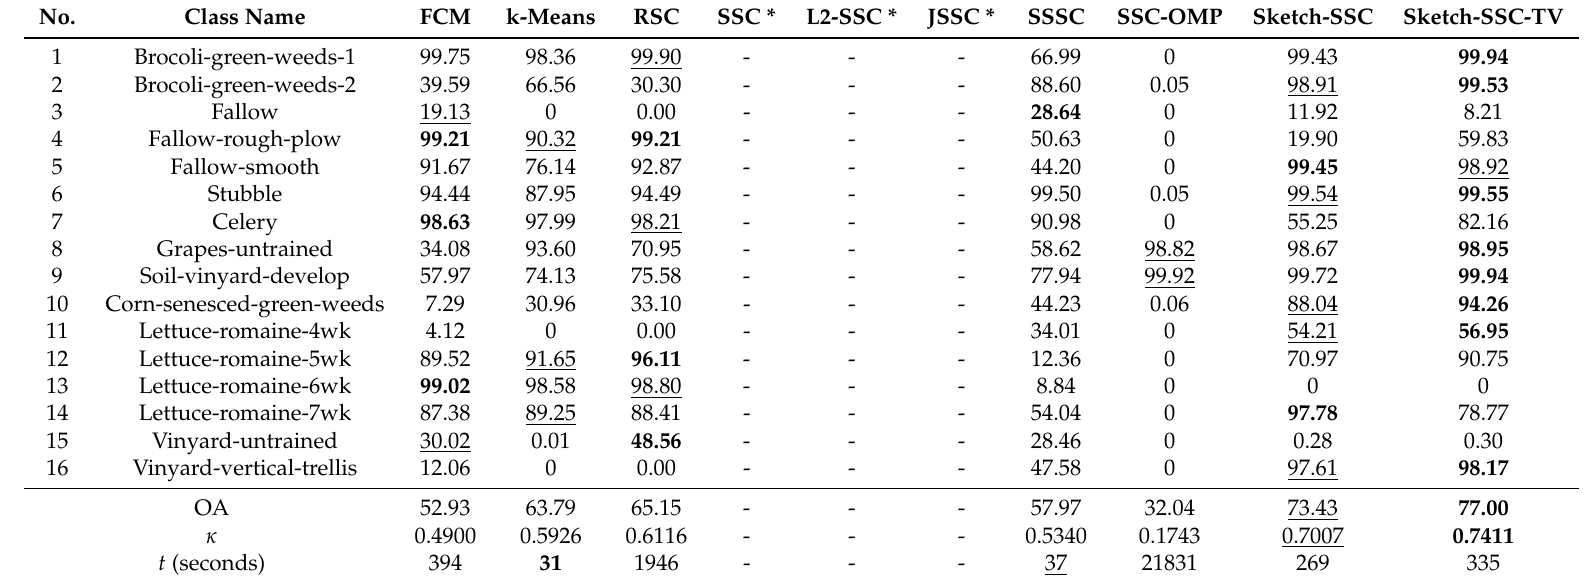
Table 5. Clustering accuracy for Salinas